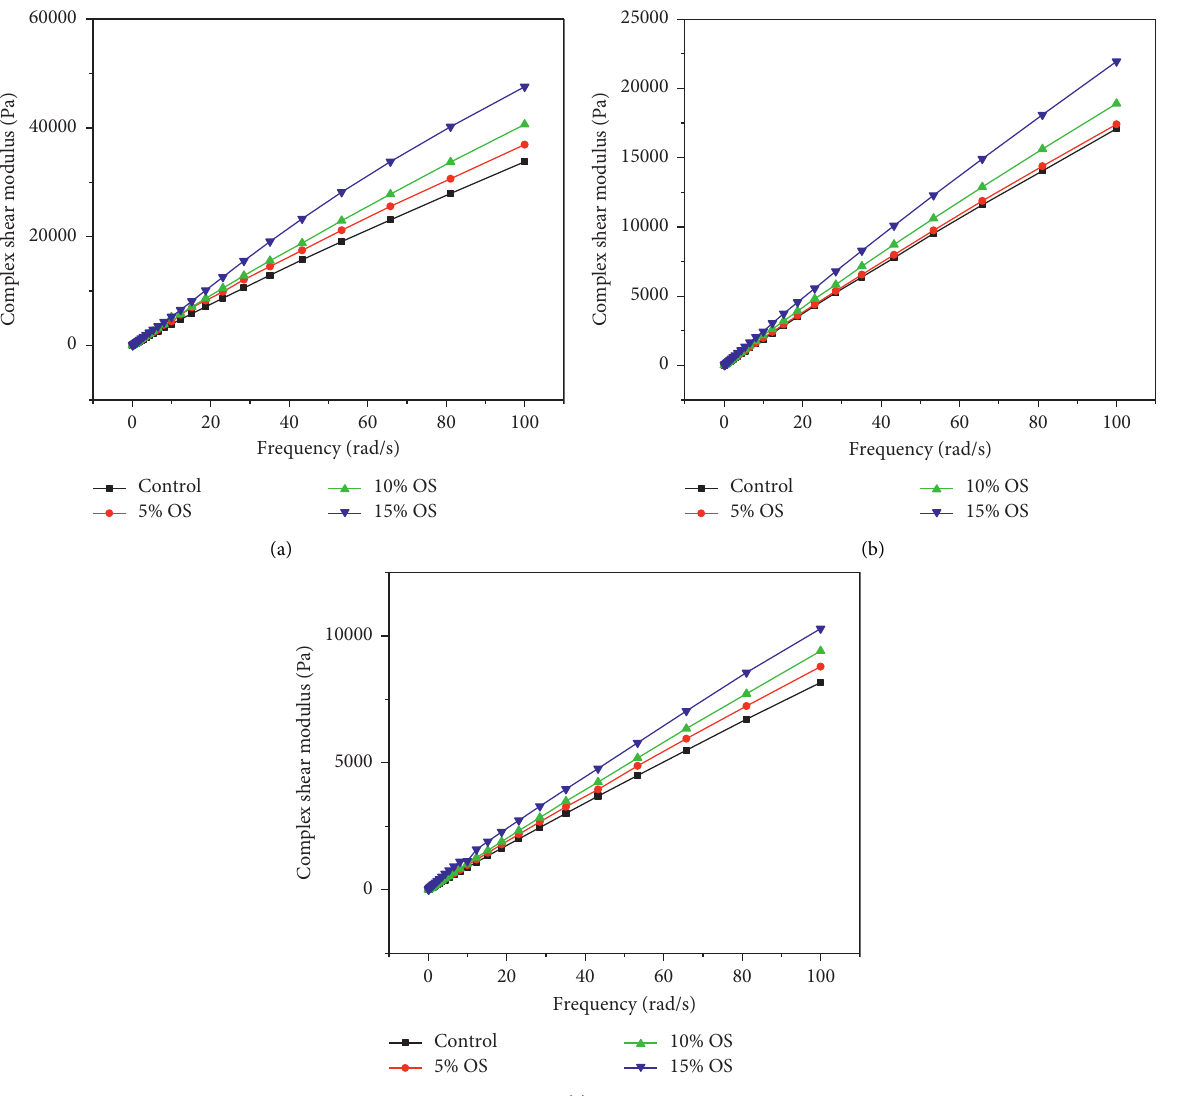
Figure 7: Complex shear modulus for various amounts of asphalt binders under fs. (a) 58 ° C. (b) 64 ° C. (c) 70 °